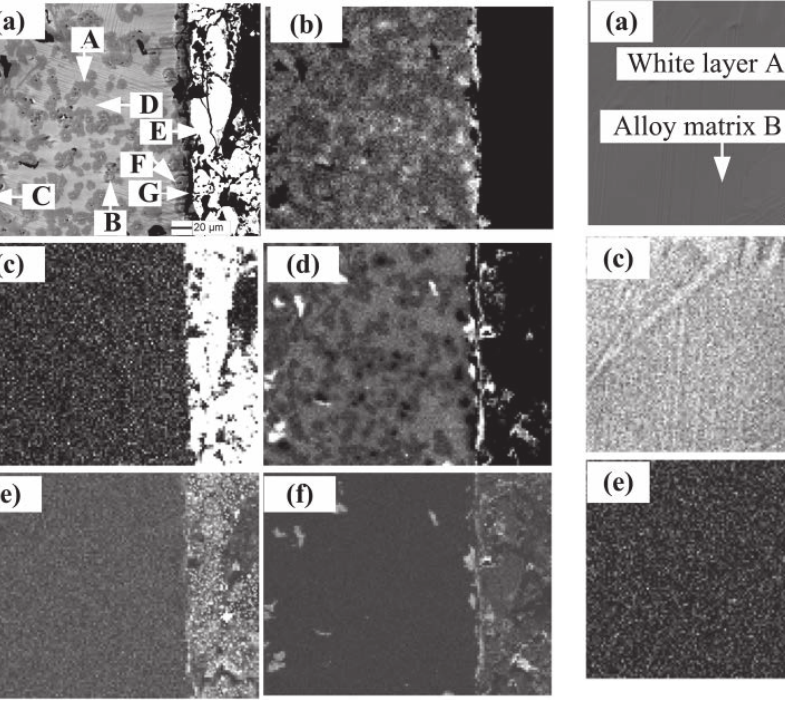
Fig. 6: (a) SEM micrograph, and SEM X-ray dot maps of (b) Ti, (c) Al, (d) Y, (e) O and (f) Zr, revealing that no reaction layer was formed on the alloy surface.